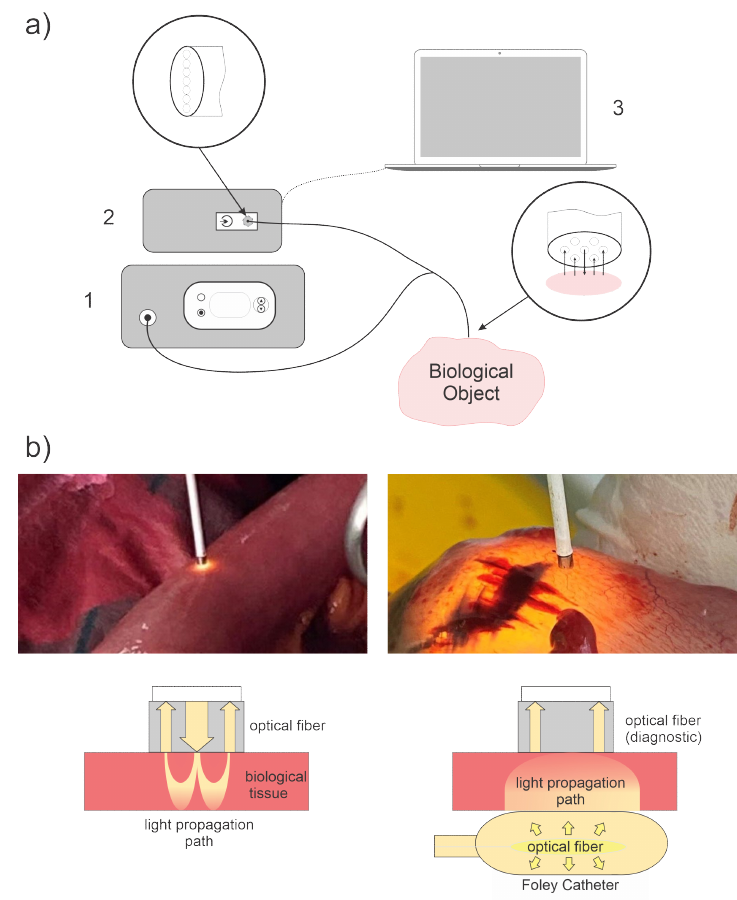
Figure 1. ( a ) The experimental setup: white light source (1), spectrometer (2) with fiber optic input, Y-shaped fiber optic probe, and PC with special software (3) for spectrum registration and processing. The fiber optic probe consisted of 7 fibers: 6 for receiving and 1 for transmitting light radiation. The location of the receiving fibers around the emitting one allows reducing the influence of the inclination of the end of the bundle on the received signal. ( b ) The geometry of diffuse scattering spectra measurements: in reflected light ( left ) and in transmitted light ( right